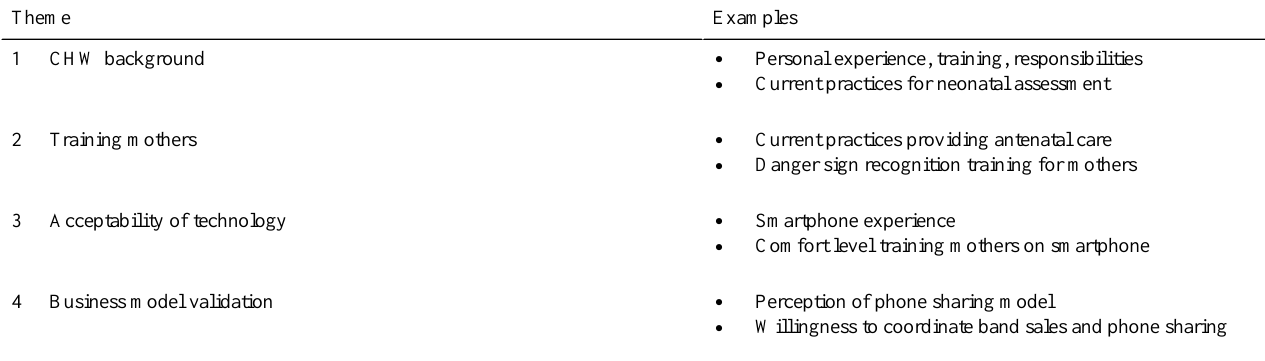
Table 2. Outline of themes explored in focus group discussions with community health workers (CHWs).